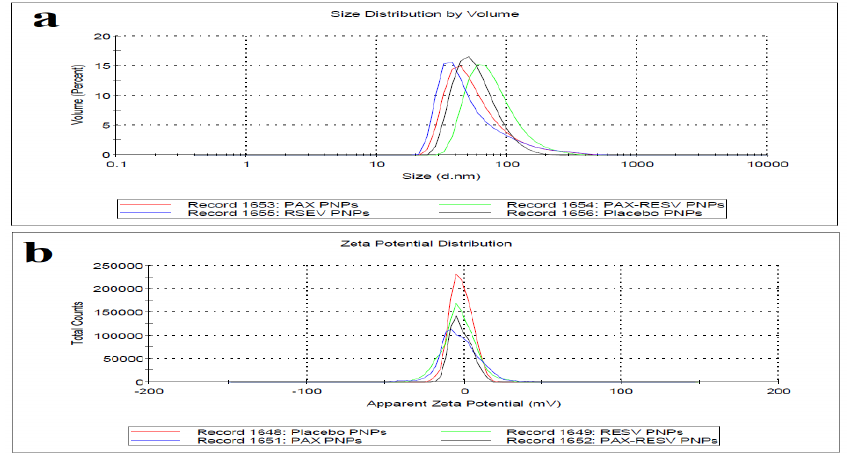
Figure 3. ( a ) Particle size distribution of optimized PAX-RESV PNPs (green line), RESV PNPs (blue line), Placebo (black line) and PAX PNPs (red line); ( b ) Zeta potential of optimized Placebo (red line), RESV PNPs (green line), PAX PNPs (blue line) and PAX-RESV PNPs (black line).